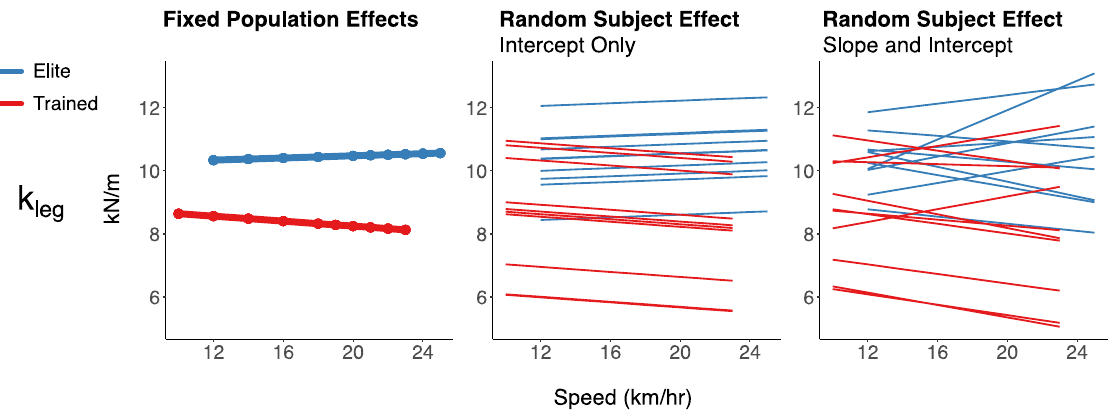
Figure 5. Leg stiffness estimates with the fixed effects model and two different random effects